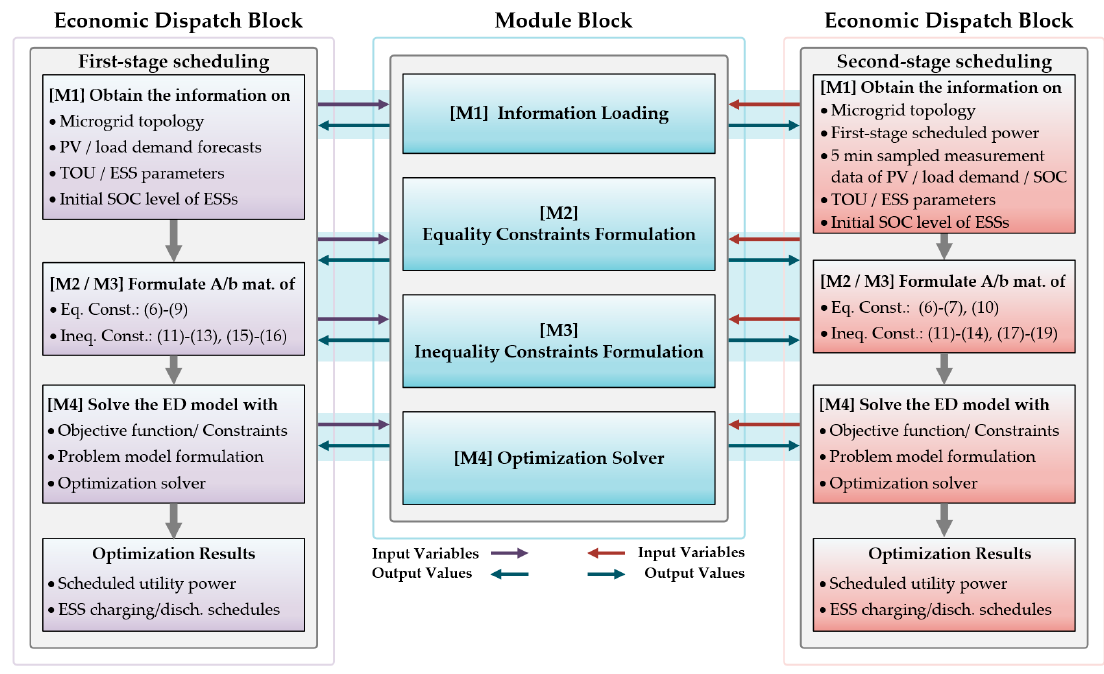
Figure 5. Coupling of the two-stage ED problem block and the module block.